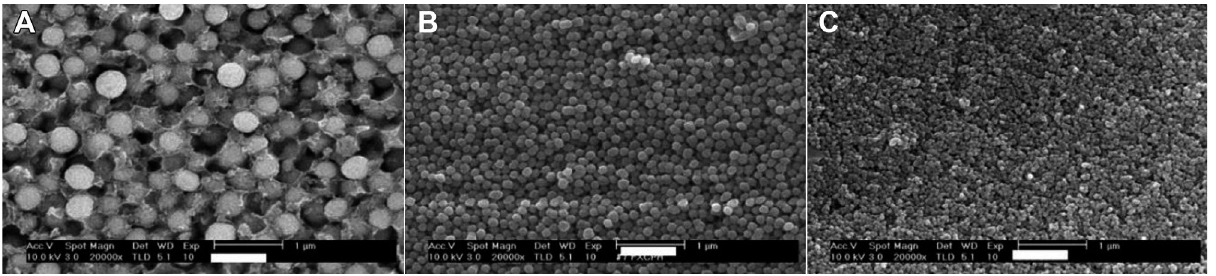
(A) Mean filler diameter of 400 nm; (B) Mean filler diameter of 200 nm; (C) Mean filler diameter of 70 nm Figure 3- Scanning electron microscopy (SEM) photographs of fillers containing experimental flowable resin composites (magnification